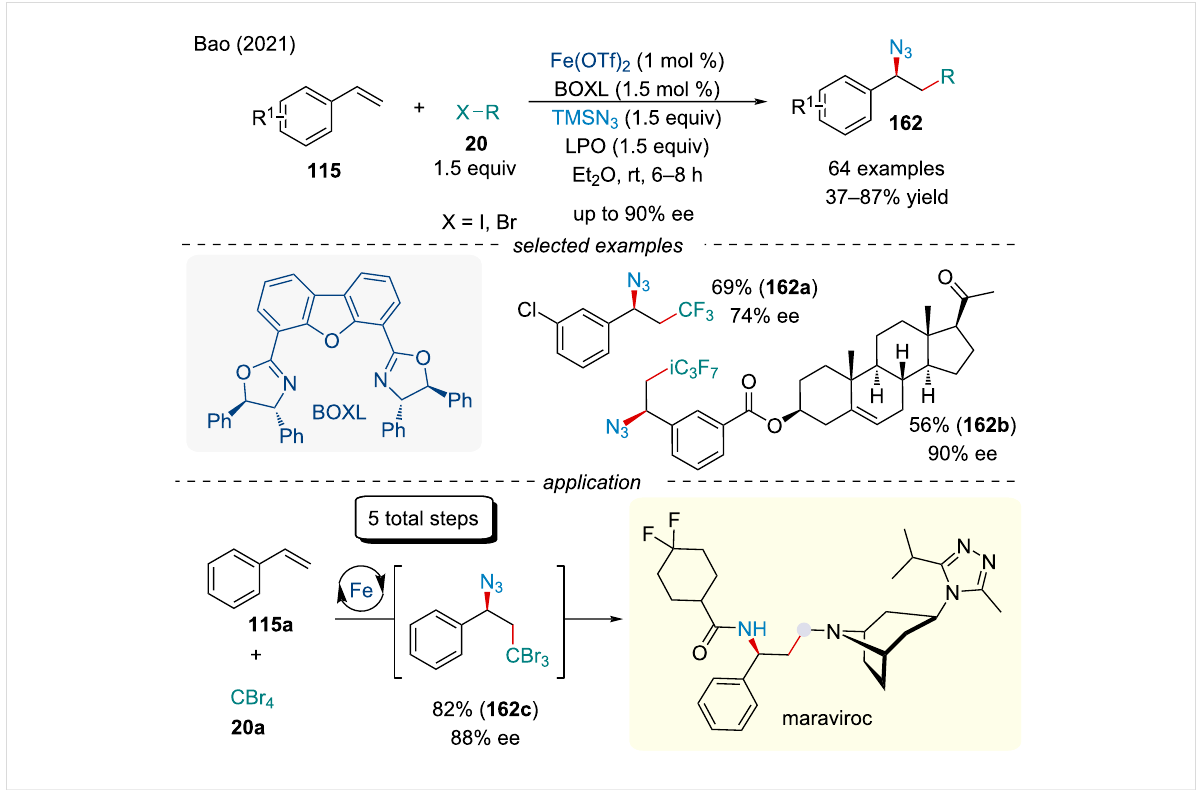
Scheme 33: Iron-catalyzed asymmetric carboazidation of styrene derivatives 115